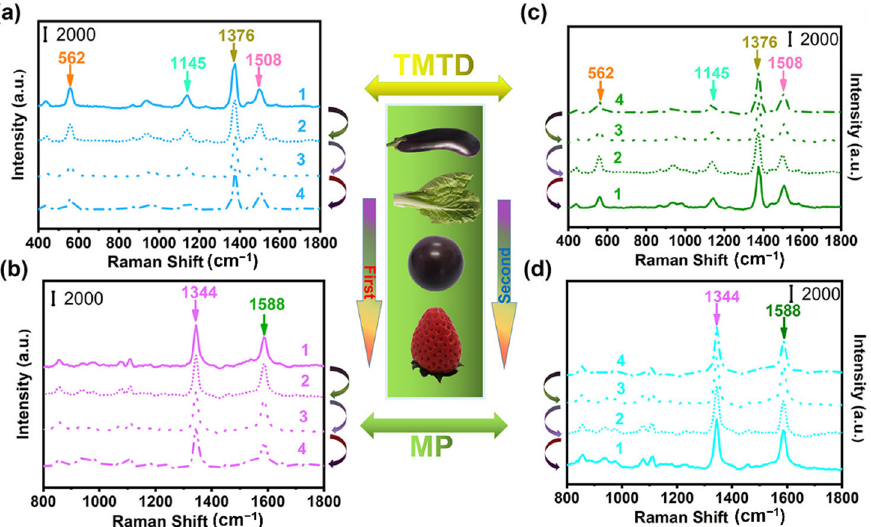
Figure 6. Recyclable SERS-based detection on eggplant (denoted as 1), Chinese cabbage (2), grape (3) and strawberry (4); first cycle for ( a ) TMTD and ( b ) MP and second cycle for ( c ) TMTD and ( d ) MP. Reprinted with permission from ref. [88]. Copyright 2020 American Chemical Society.